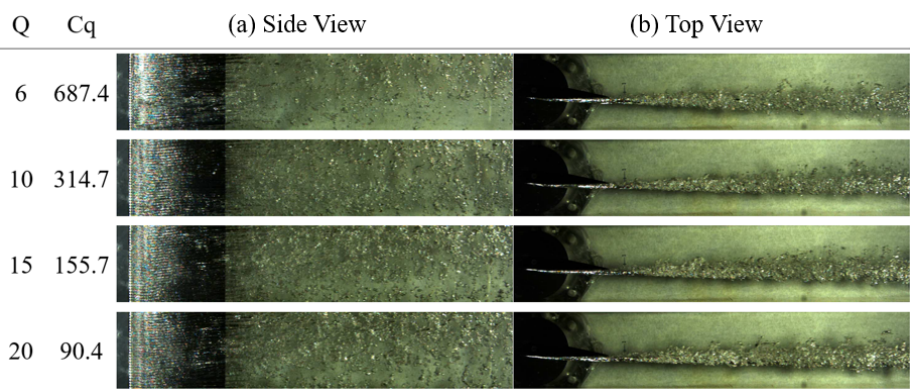
Figure 4. The instantaneous images showing the bubbles at Fn = 70.7 at Q = 6 to 20 SLPM . ( a ) Side view at Q = 10 SLPM . ( b ) Top view at Q = 10 SLPM . (Multimedia view.)